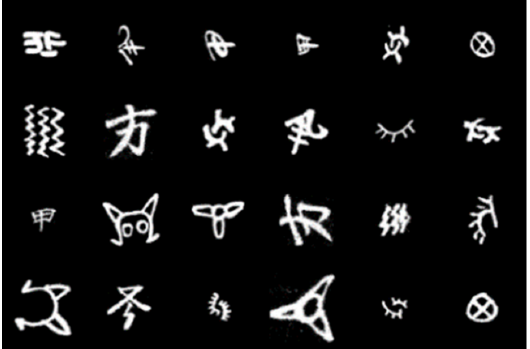
Figure 3. Image obtained via the image synthesis